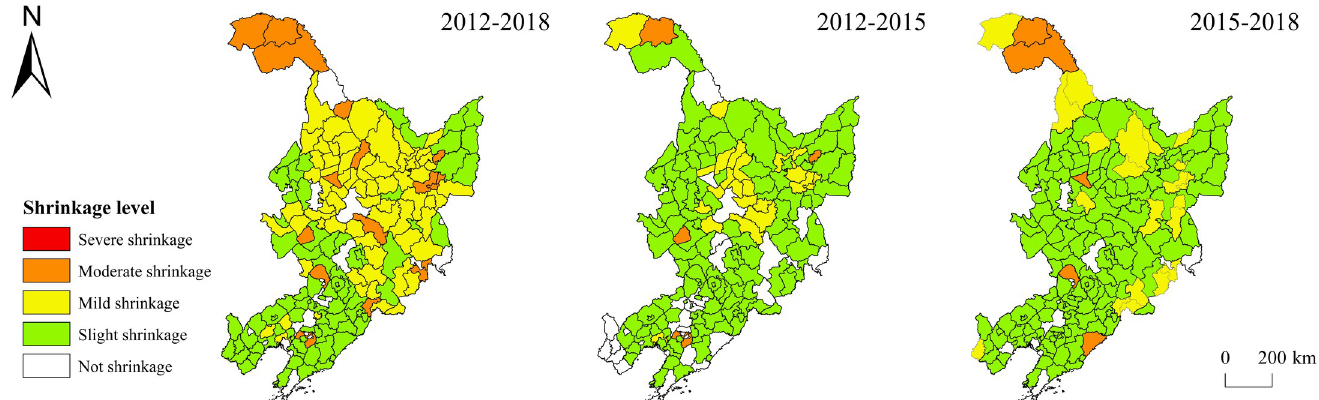
Fig 3. Spatial difference of population-related shrinkage of the three northeastern provinces. Note: The basic map came from a public map from the standard map service website of the Ministry of Natural Resources of China. The drawing approval number is GS (2016)1593.